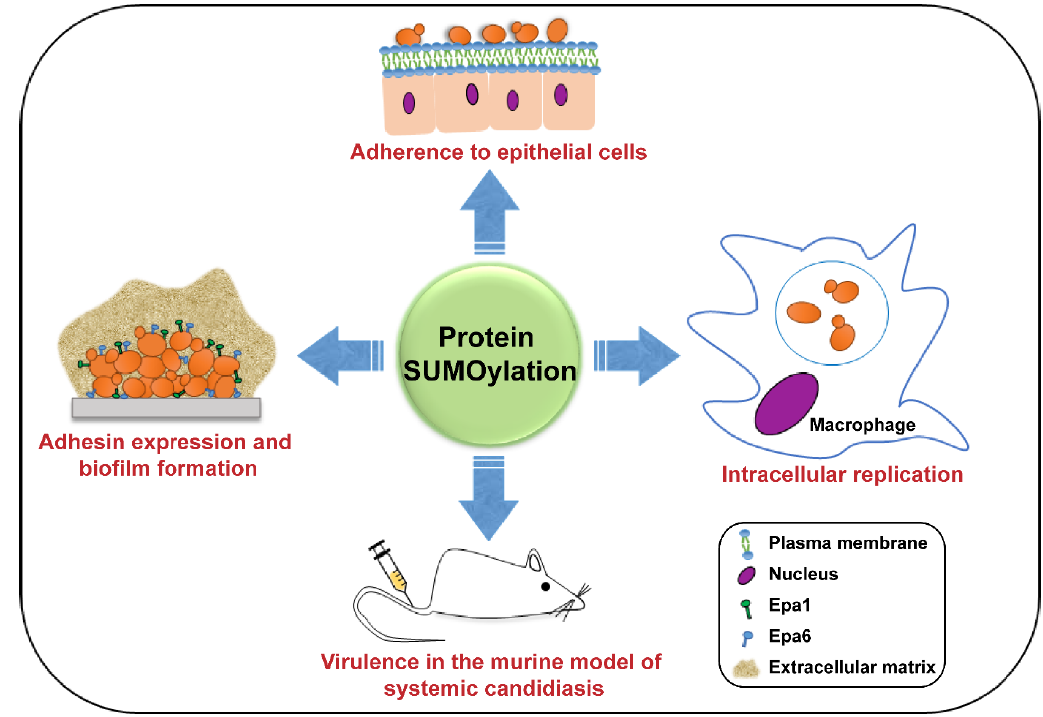
Figure 3. A schematic illustrating the roles of SUMOylation in the pathogenesis of C. albicans and C. glabrata . SUMOylation is required for adherence to epithelial cells, biofilm formation and intracellular proliferation of C. glabrata in human macrophages. SUMOylation also modulates the virulence of C. albicans and C. glabrata in mice.